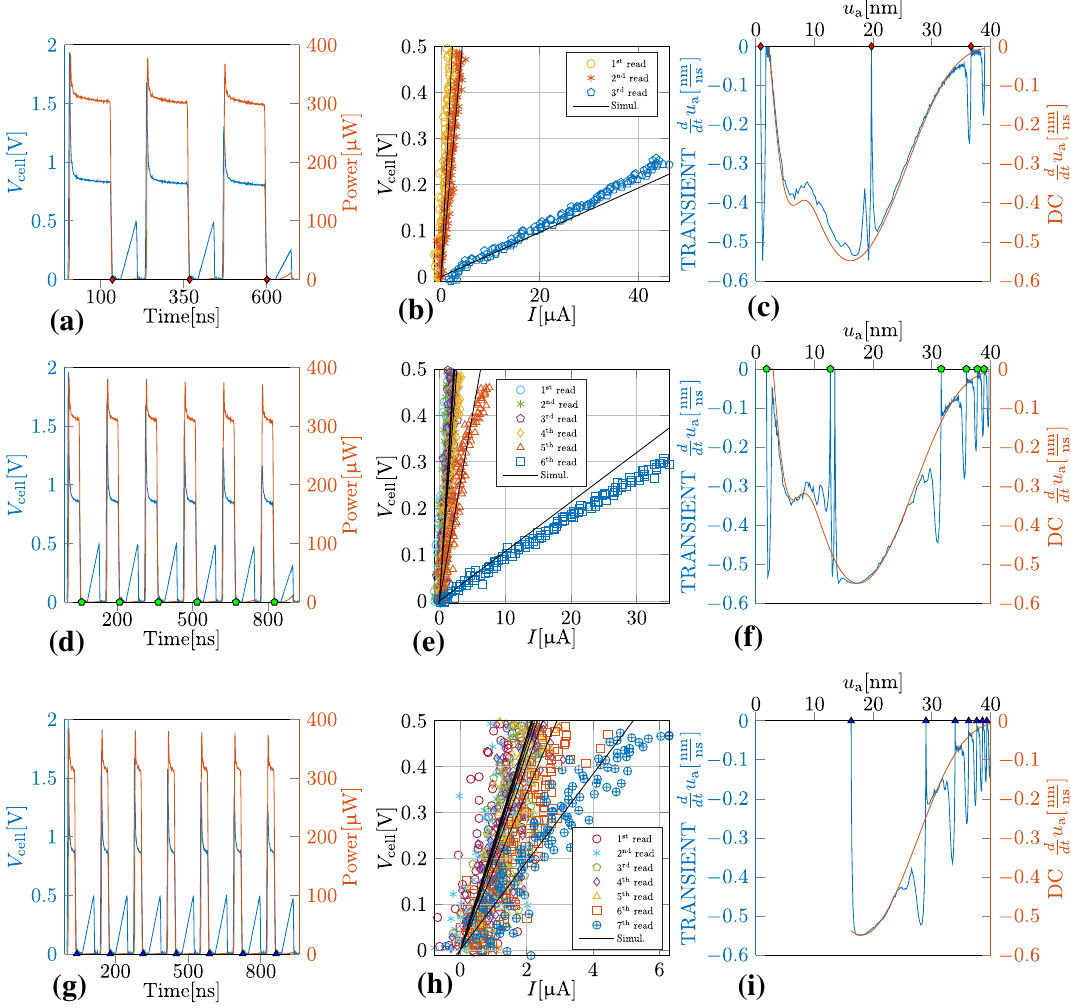
Figure 7. Experimental validation of DRM. Panels ( a – c ), ( d – f ) and ( g – i ) correspond to three separate experiments to measure the DRM. (Left column) Experimentally measured V cell and the corresponding dissipated electrical power, P . Each square-shaped high–current write pulse is interleaved with a below threshold triangular read pulse (see Methods for more details). Between experiments, the key difference is the V cell characteristics corresponding to the number and duration of the write pulses. (Center column) The I − read pulses are shown. The effective amorphous thickness, u a , is assumed to be directly proportional to the slope of these curves as per Eq. (7). (Right column) Based on the power signals shown on the left column, the u a V cell characteristics shown in the center column and the memristive state equations, estimates based on the I − experimental DRMs are obtained (blue traces). Also shown are the DRMs based on the steady-state values of the power signals (red